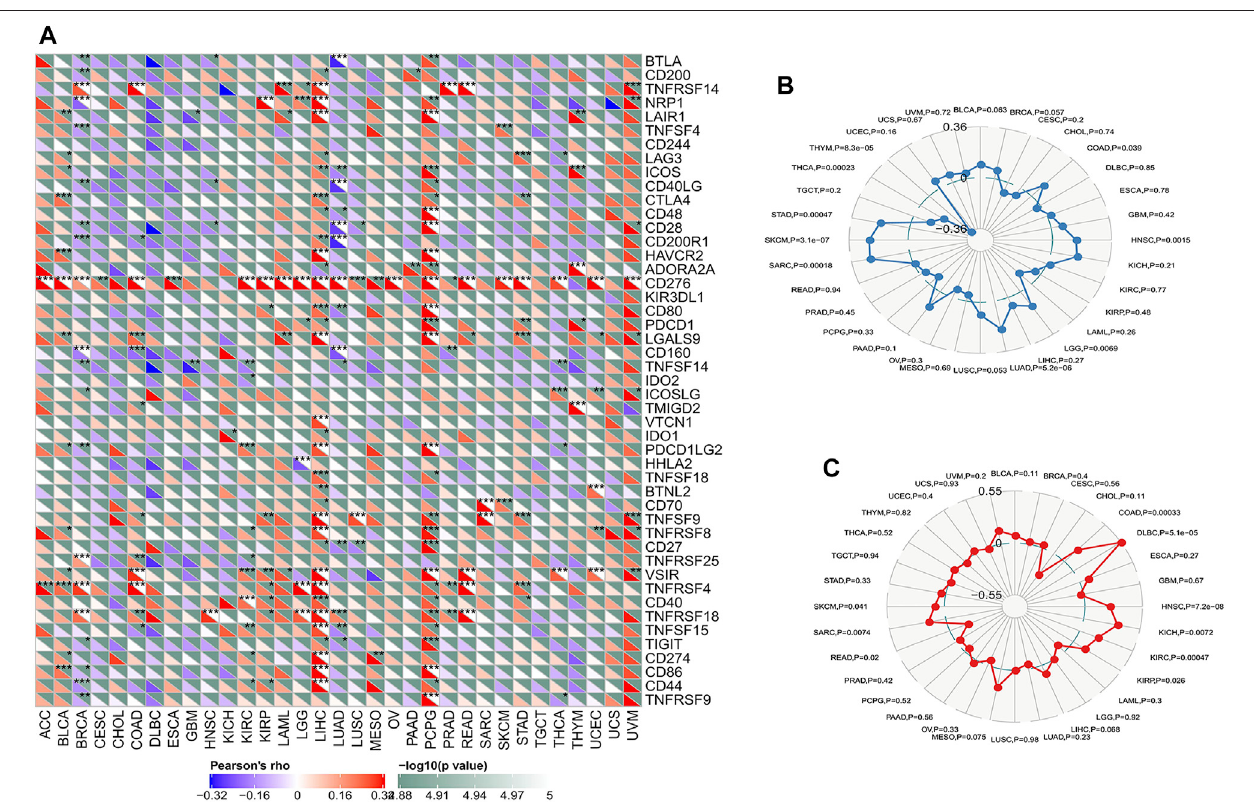
FIGURE 5 | The relationship between ATG101 expression and immunoreactivity. (A) The correlation between immune checkpoint gene expression and ATG101 expression level. * p < 0.05, ** p < 0.01, *** p < 0.001. (B) The relationship between ATG101 expression level and TMB. (C) ATG101 expression level and microsatellite instability (MSI) in tumour